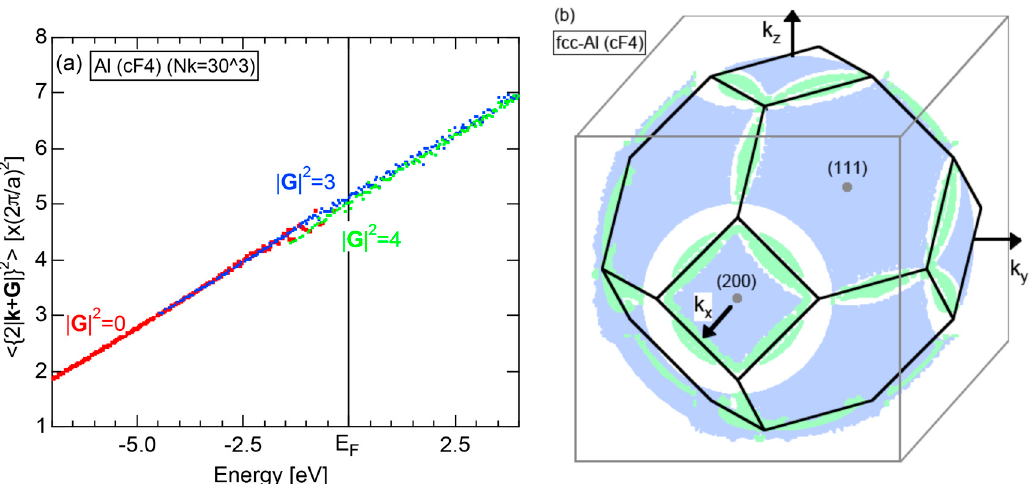
Figure 18. ( a ) The Hume-Rothery plot for tri-valent Al (cF4). The data points in red color are contributed from electronic states in the first zone, those in blue from the second zone and those in green from the third zone in the extended zone scheme. Contributions from all three zones coexist over the energy range from − 4.4 to − 0.5 eV. They are summed up to constitute the Hume-Rothery plot, as shown in Figure 20b in its complete form; ( b ) The resulting Fermi surface of Al (cF4) in the extended zone scheme. The blue and green colors are chosen to represent the Fermi surfaces overlapped into the second and third zones so as to meet with colors in ( a ), respectively.